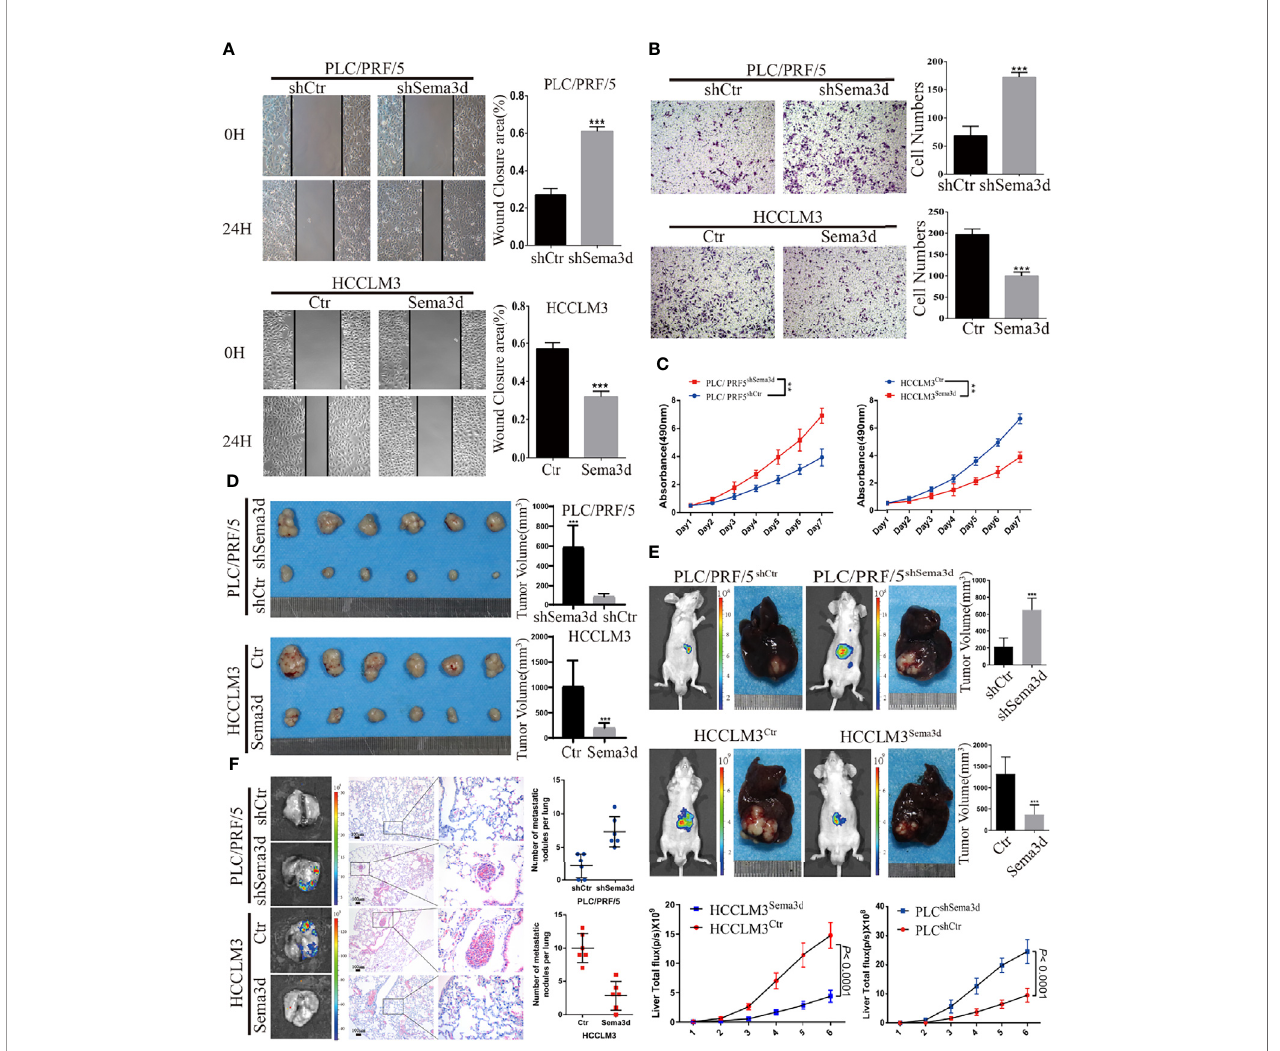
FIGURE 3 | Sema3d restrains HCC migration, invasion, proliferation, and metastasis in vitro and in vivo . (A) Wound-healing assay detected the migratory PLC/PRF/ 5 shSema3d and HCCLM3 Sema3d , as well as the corresponding control cells ( n = 6 for each group). (B) A Transwell invasion assay was performed to detect the invasive capacities of HCC cells ( n = 6 for each group). (C) MTT assay detected the proliferation capacities of Sema3d-interfered HCC cells ( n = 6 for each group). (D) In subcutaneous tumors derived from PLC/PRF/5 shSema3d and HCCLM3 Sema3d cells and their control cells, tumor volumes were calculated with the formula (length × width 2 )/2. (E) At week 6, representative bioluminescent images monitored by IVIS and orthotopic xenograft tumors were shown, as well as the volume of orthotopic tumors and the growth curves constructed by the quanti fi ed bioluminescent signal ( n = 6 for each group). (F) Representative bioluminescent images and HE staining images of lung tissue and a number of pulmonary metastasis nodules in different groups were shown (upper panel). ** p < 0.01; *** p <